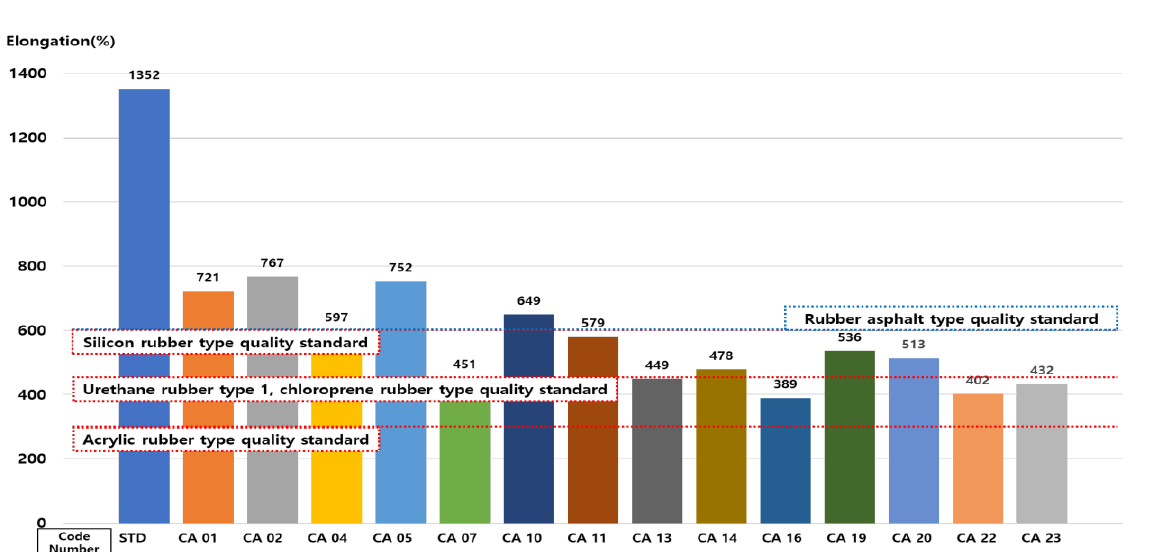
Figure 17. Comparison of composite additive elongation test results and quality